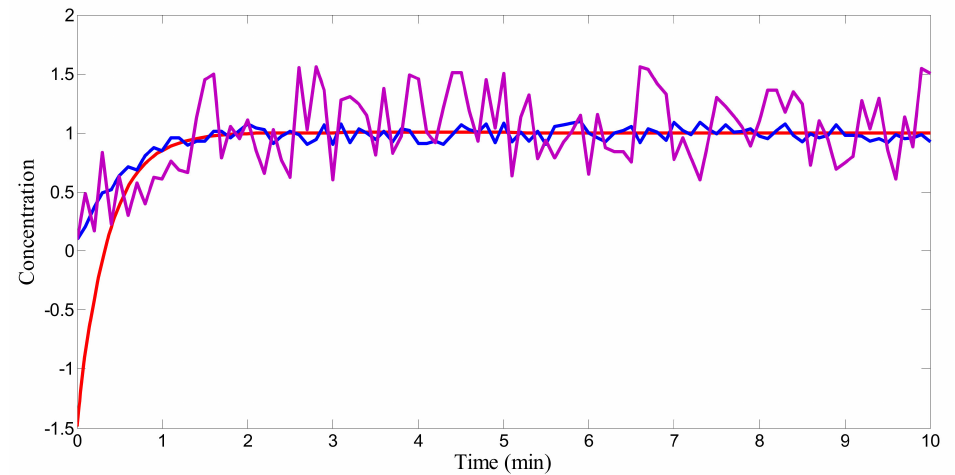
Figure 5. State variable X 1 : (red: Dynamics obtained with feedback linearization (FBL), violet: Dynamics obtained with disturbance injected to the model, blue: Dynamics obtained with disturbance injected to the model and applying sliding mode